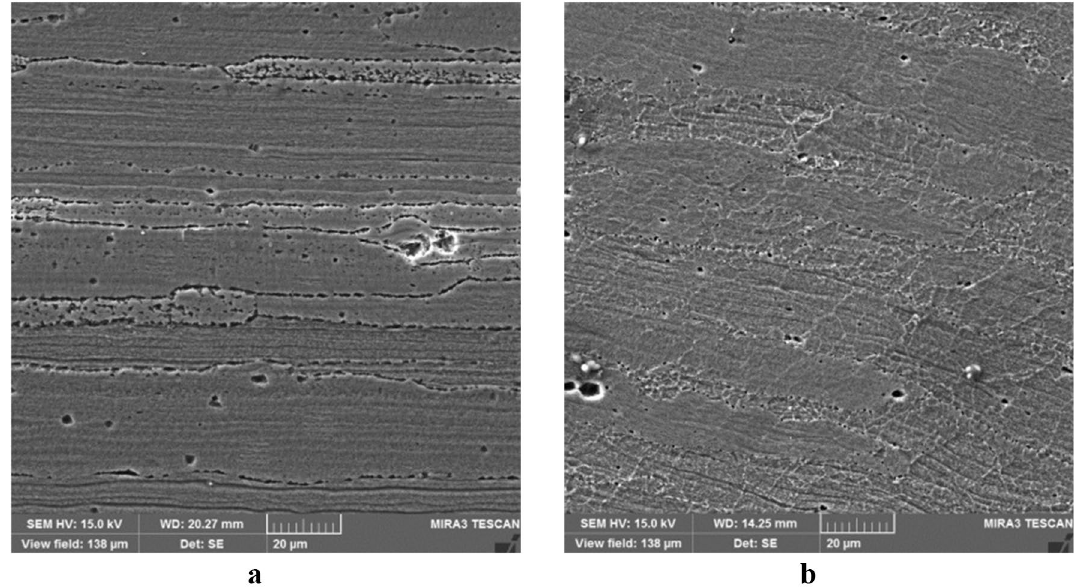
Figure 15. SEM images of the stir zone in the low-quality samples: ( a ) conical pin (c12), ( b ) threaded cylindrical pin (b17).